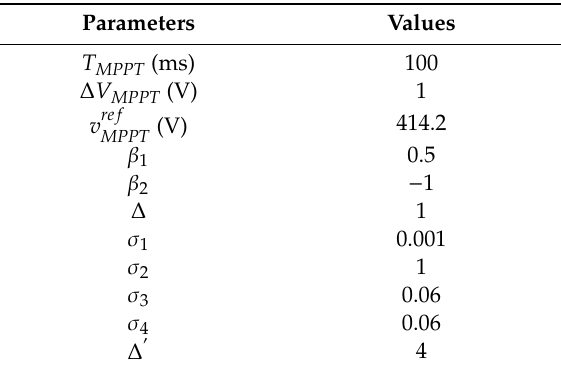
Table 3. Control